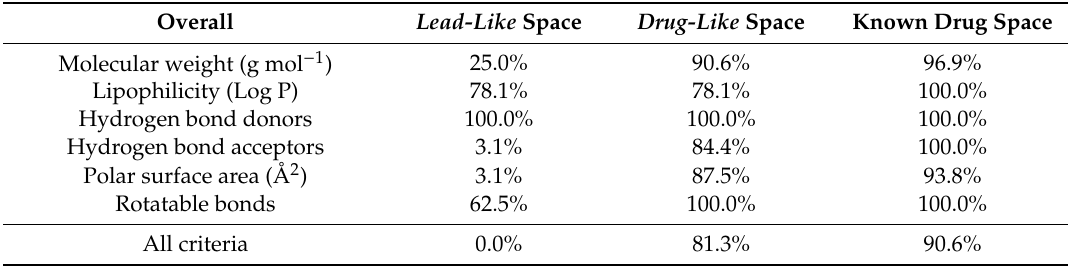
Table 6. Compounds from fungi and their inclusion within the defined chemical